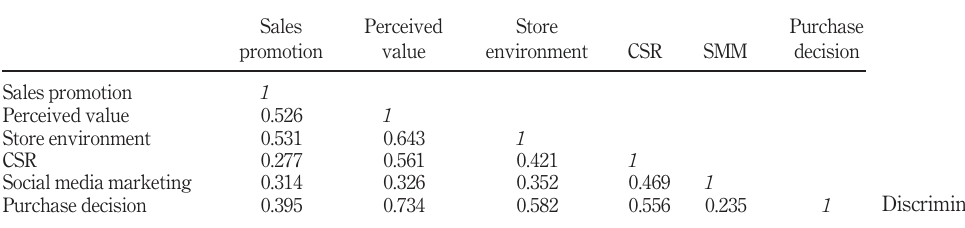
Table I. Discriminant validity